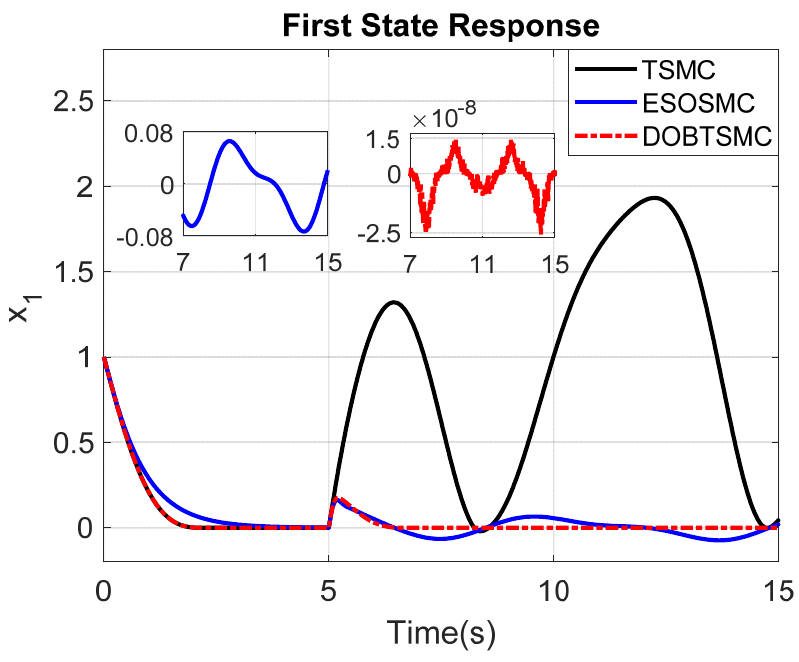
x . Figure 1. Response trajectory of the state x 1